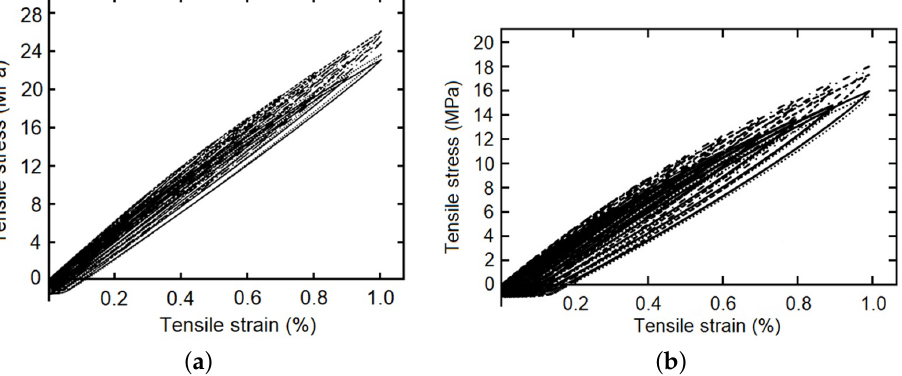
Figure 5. Loading–unloading tensile tests with strain as entrance signal, five specimens, ( a ) with 22 wt%, and ( b ) with 28 wt%.